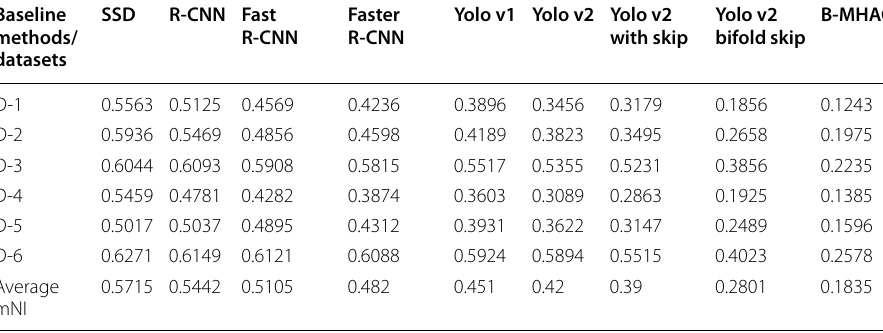
Table 4 Evaluation of the proposed method using mNI Baseline